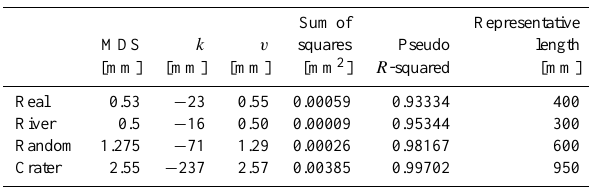
Table 3. Parameters of Eq. (1) when changing length ( l ), good- ness of fit expressed as the sum of squares (SS) and the pseudo R -squared, and representative length for the four microtopography types.